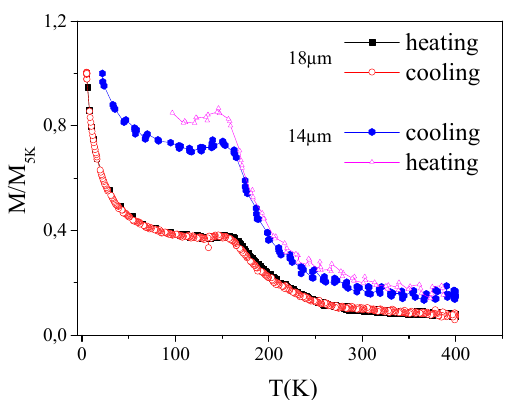
Figure 39. Temperature dependence of normalized magnetization measured for the as-prepared Ni-Mn-Ga glass-coated microwires. Reproduced from reference [117], Figure 2.